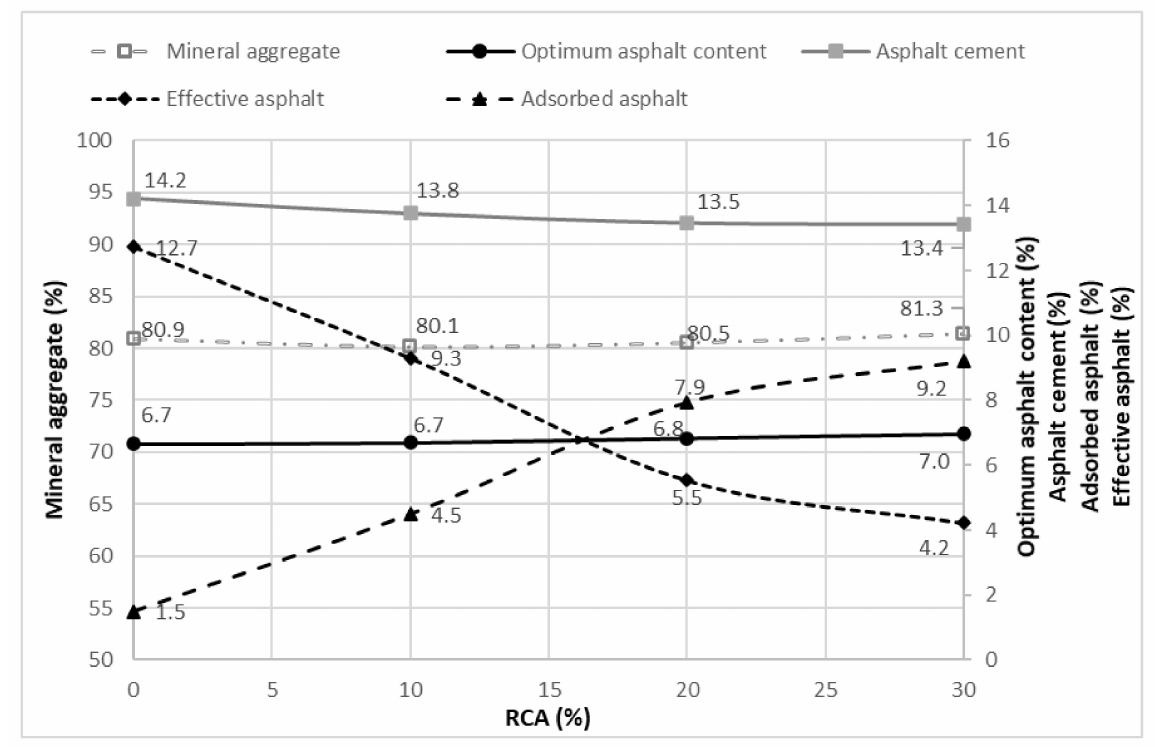
Figure 17. Correlation of the mineral aggregate percentages versus the optimum asphalt content, asphaltic cement, absorbed asphalt and effective asphalt.